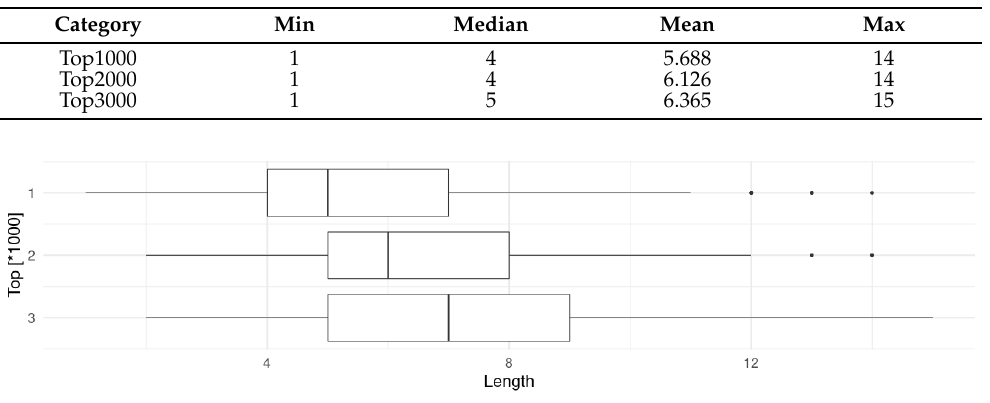
Table 1. Summary statistics of lengths of most frequent words in English.